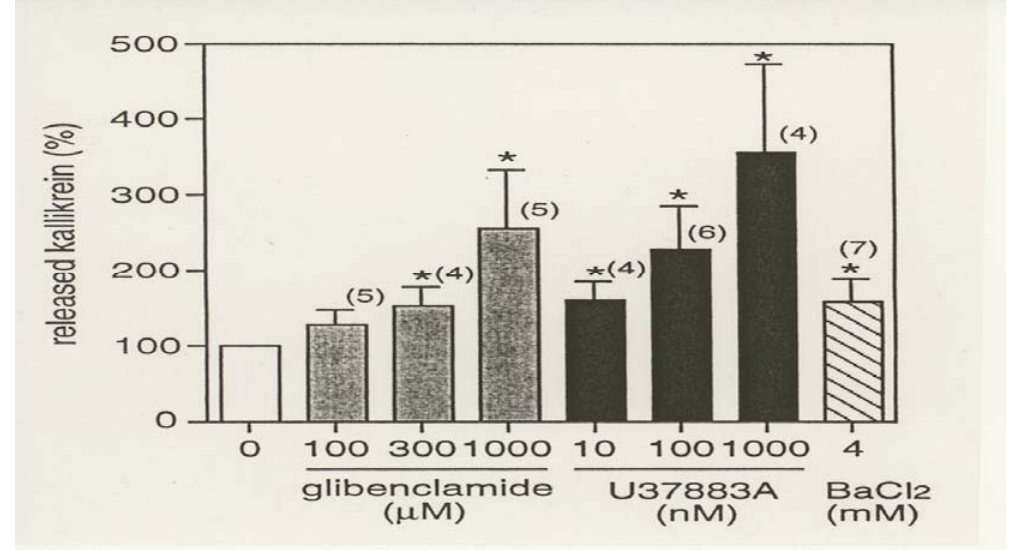
Figure 3. Effects of ATP-sensitive potassium channel blockers on the release of kallikrein from sliced cortex of rat kidney. A slice of kidney cortex was isolated from Sprague-Dawley strain rats and superfused with 10 mM HEPES (pH 7.4) +140 mM NaCl+1 mM CaCl at a flow rate of 0.14 ml/min for 60 min. Then each ATP-sensitive 2 potassium channel blockers, glibenclamide (shaded columns), U37883A (closed columns), and barium chloride (hatched column), was added into the solution and the superfused solution was collected. Values are mean ±S.E.M. Numbers of rat used are indicated in parenthesis. * P < 0.05, compared with the solution without the blockers (open column) by Student’s t-test (reproduced from Ref. [68] with